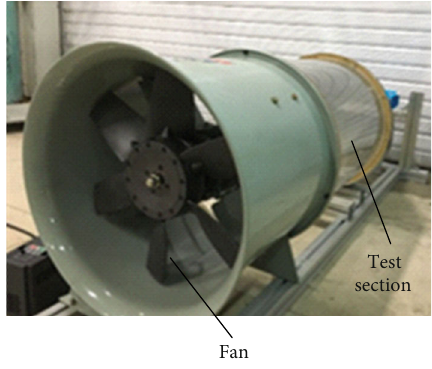
Figure 4: Experimental system physical